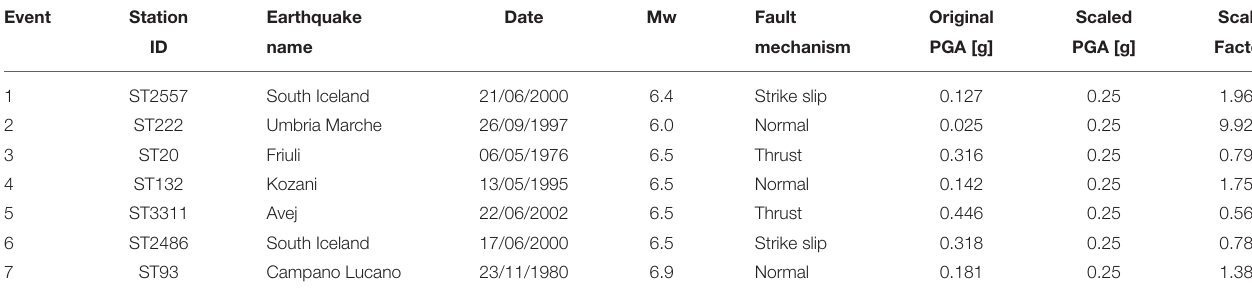
TABLE 5 | Characteristic of selected ground motion